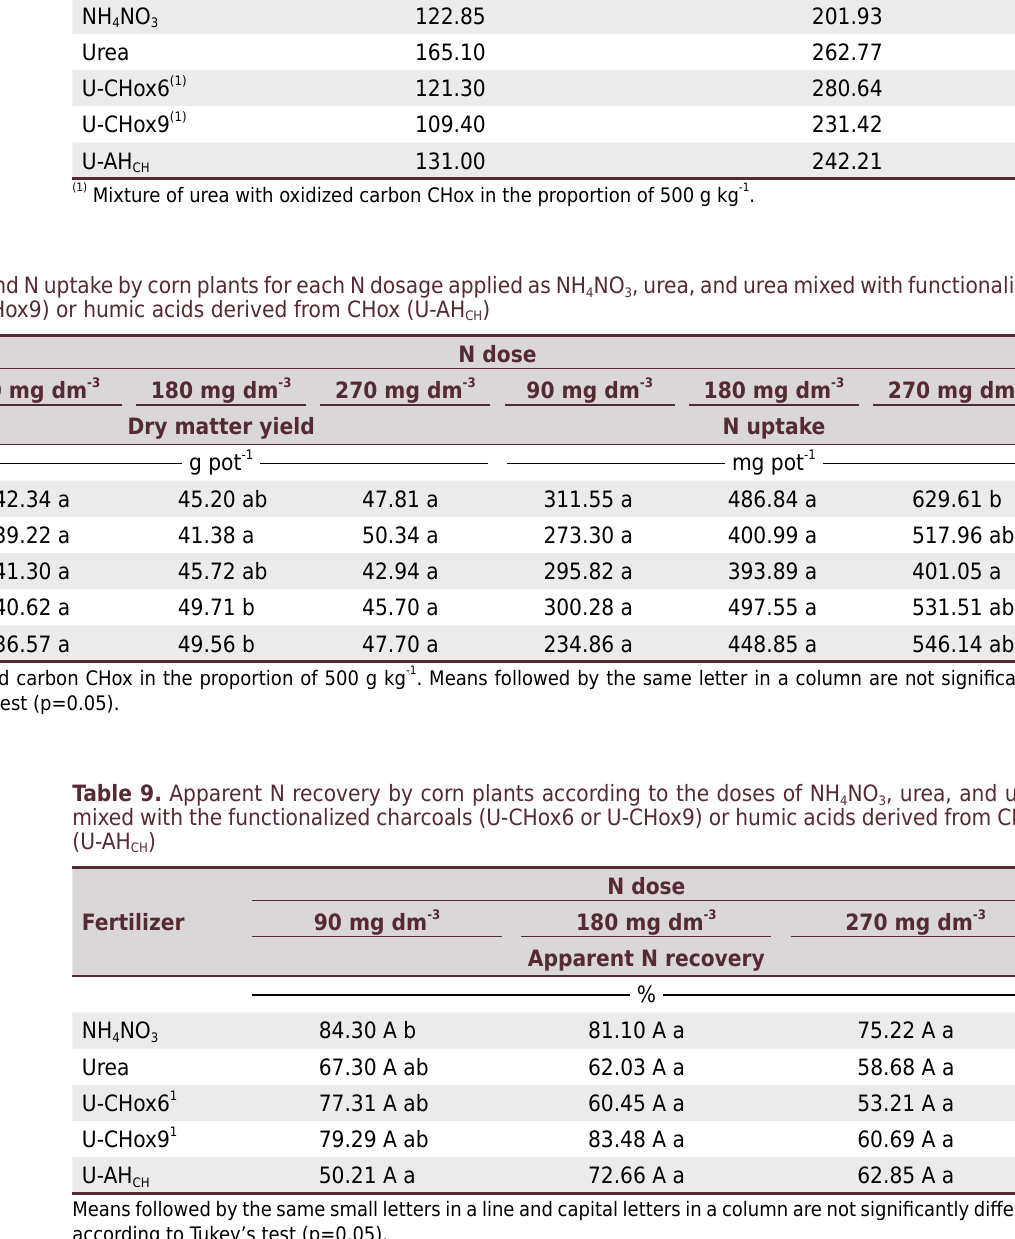
Means followed by the same small letters in a line and capital letters in a column are not significantly different according to Tukey’s test